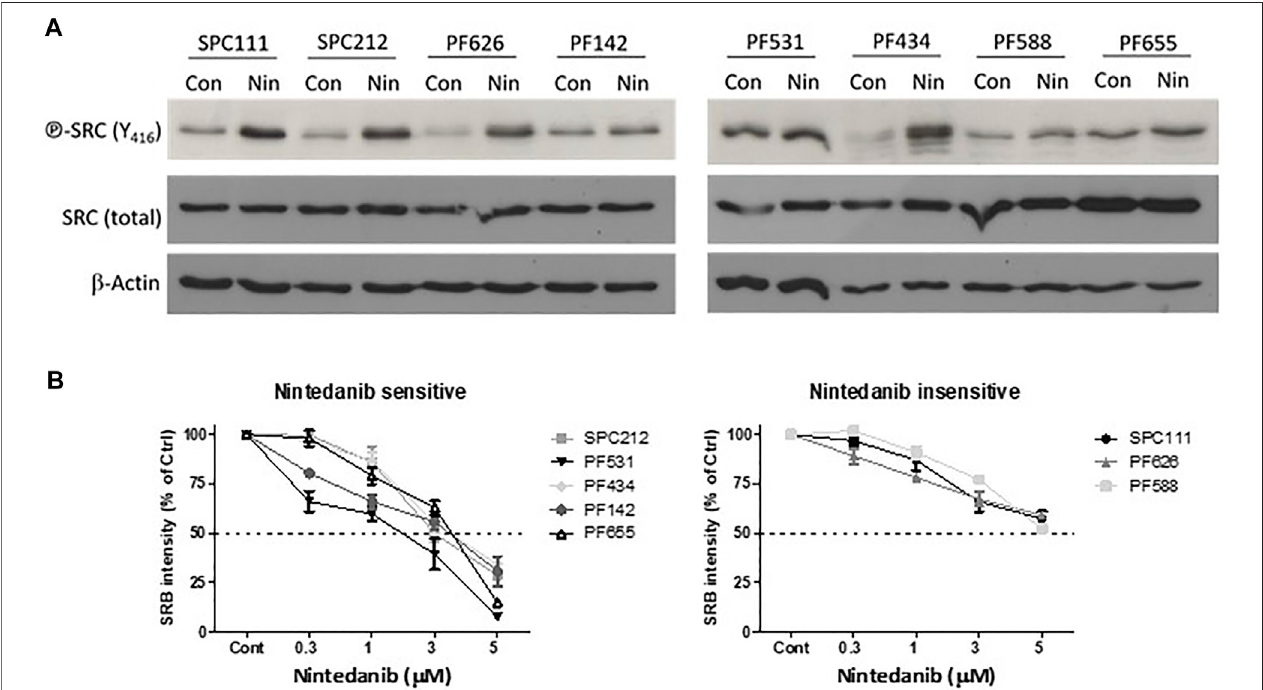
FIGURE1| NintedanibdoesnotinhibitSRCinMPMcelllines (A) Cellsweretreatedwith1 μ Mnintedanibfor24 handproteinlysateswereanalyzedbywesternblot (B) Cells were treated with nintedanib for 72 h. Cell viability was analyzed with SRB assay. All experiments were performed in triplicates. Bars represent means ± SEM from three independent